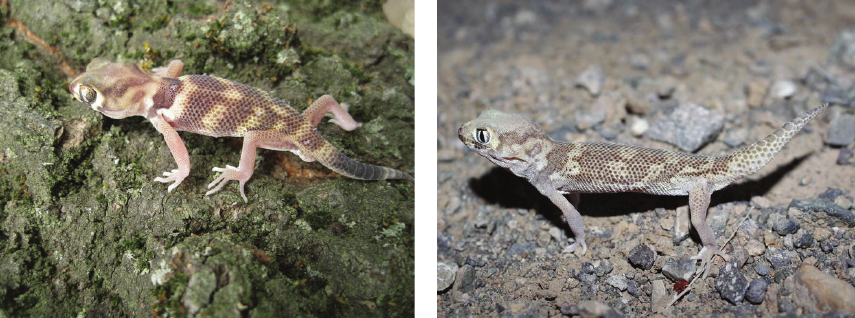
Figure 2: Teratoscincus bedriagai in Hassan Abad, Iran.